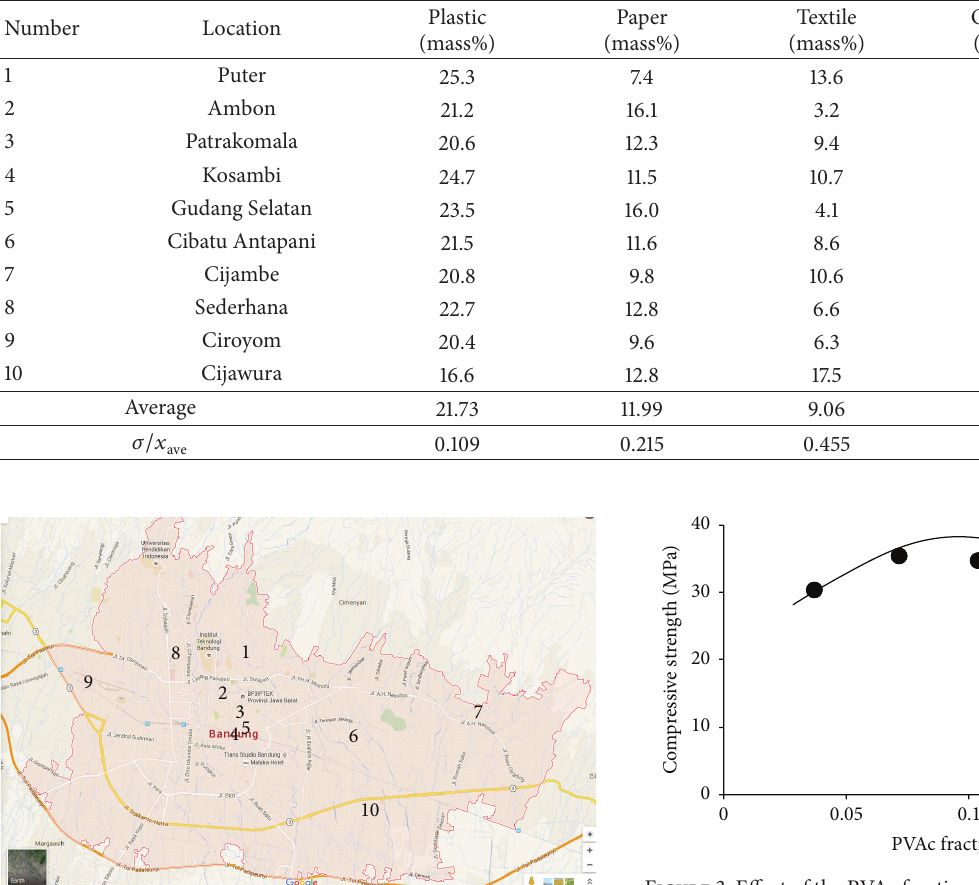
Figure 3: Effect of the PVAc fraction on the composite compressive strength. The synthesis parameters used were as follows: 6 g GL, 3